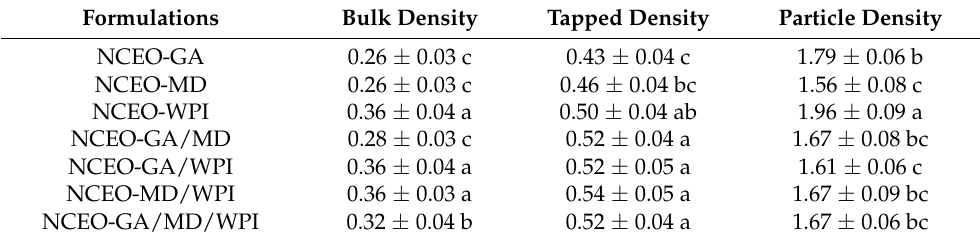
Table 5. Bulk, tapped, and particle density of CEO nanocapsules.